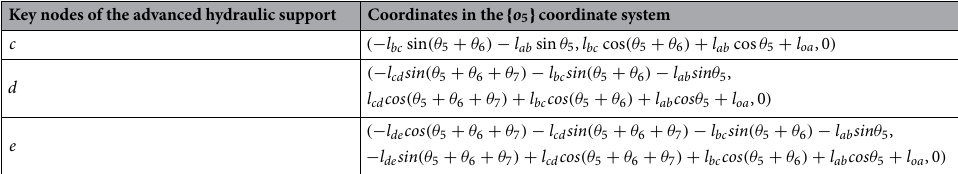
Table 14. Coordinates of nodes c , d , and e in the { o 5 } coordinate system.